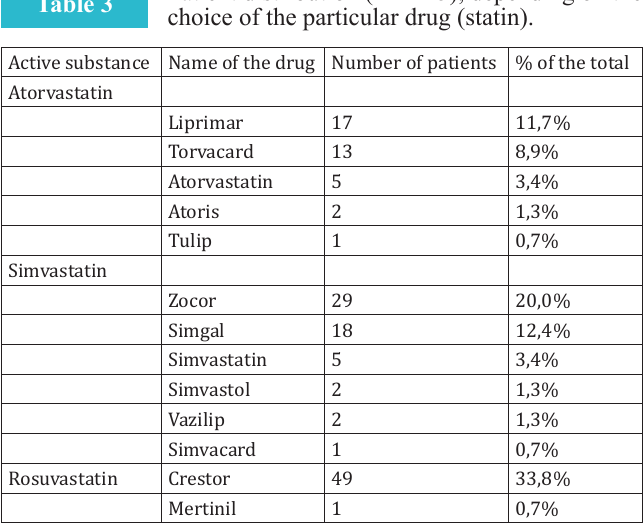
Active substance Name of the drug Number of patients % of the